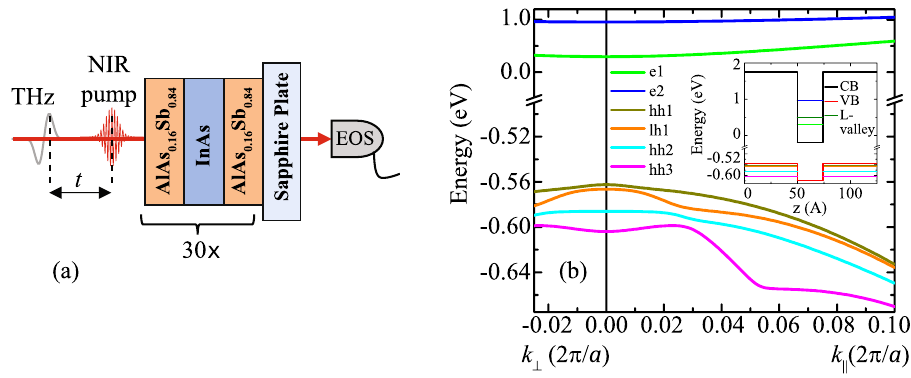
Figure 1. Schematic of the optical pump and THz probe experimental geometry ( EOS = electro-optic sampling). ( b ) Band structure 15 of the InAs MQW superlattice. The inset shows the band minima and maxima of a single QW with confined energy levels at k = 0 cm − 1